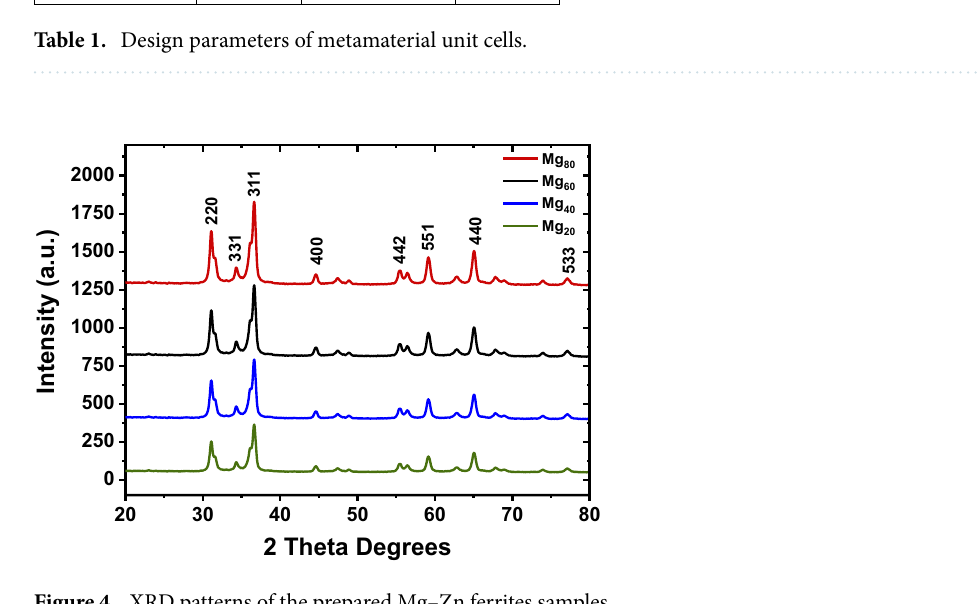
Figure 4. XRD patterns of the prepared Mg–Zn ferrites